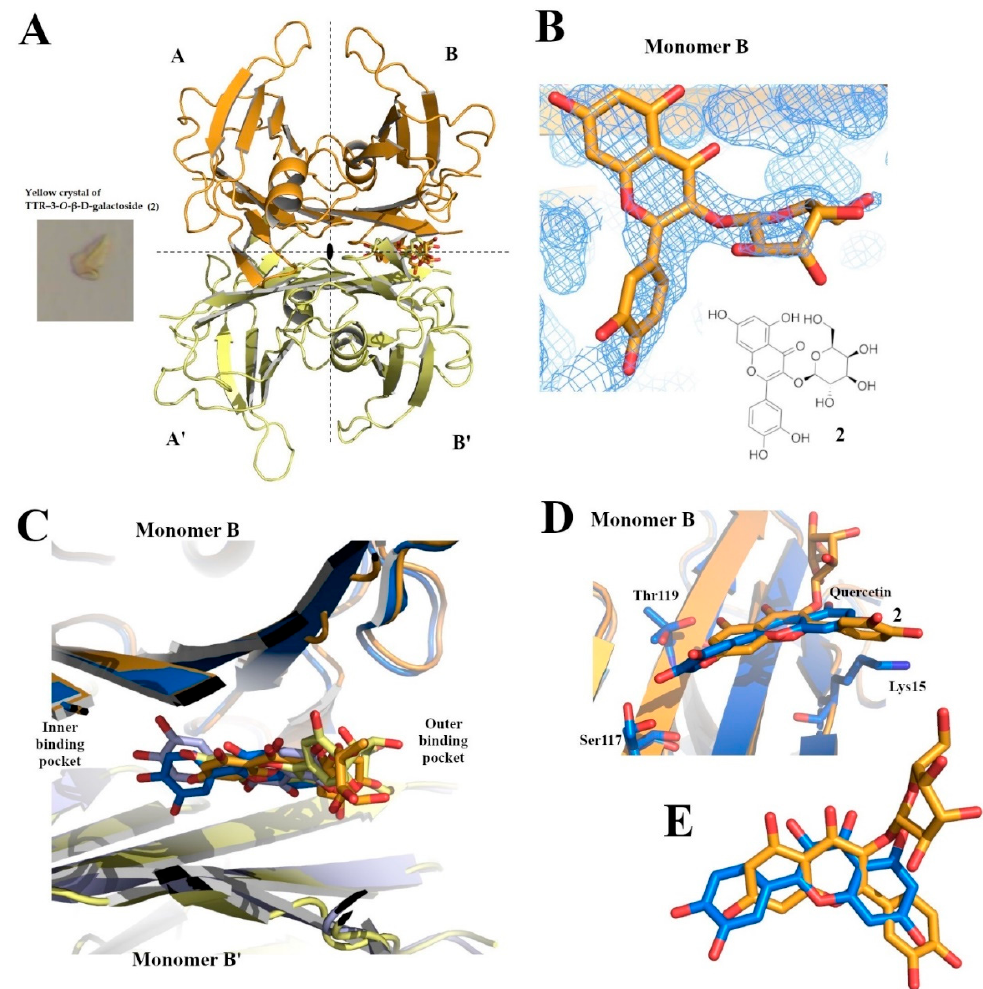
Figure 6. Graphic representation of QUE 3- O - β - D -galactopyranoside in complex with wt-TTR. ( A ) QUE 3- O - β - D -galactopyranoside bound to TTR tetramer binding site B/B’. ( B ) Zoom of ligand contoured by its electron density (weighted 2Fo-Fc, contoured at 1.0 σ ). Chemical structure of compound 2 . ( C ) Superposition between the crystal structure of quercetin complexed with wt-TTR (pdb code 4WNJ) colored in marine and light blue (symmetric) and TTR–QUE 3- O - β -D-galactopyranoside complex (bright orange and pale yellow symmetric). ( D ) Comparison between the two ligands in T4-TTR binding site (QUE colored marine and QUE 3- O - β - D -galactopyranoside in bright orange). ( E ) Zoom of ligands superposition (QUE colored marine and QUE 3- O - β -D-galactopyranoside in bright orange). Structural figures have been made with PyMol [33], modifying the scripts previously used [64], and the images were assembled using GNU Image Manipulation Program (GIMP)